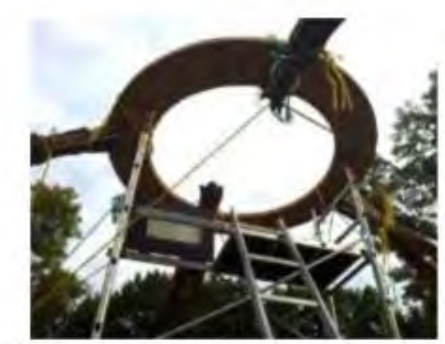
Figure 10. Ring beam in structure (Boisbushet, 2013)